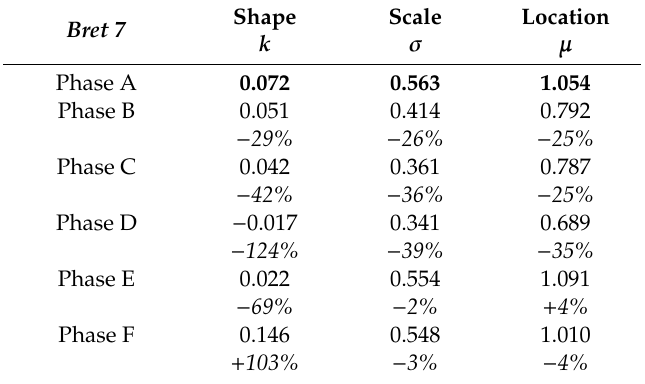
Table 7. Comparison of GEV distribution parameters for all phases for wave case Bret 7 and percentage change from Phase A.